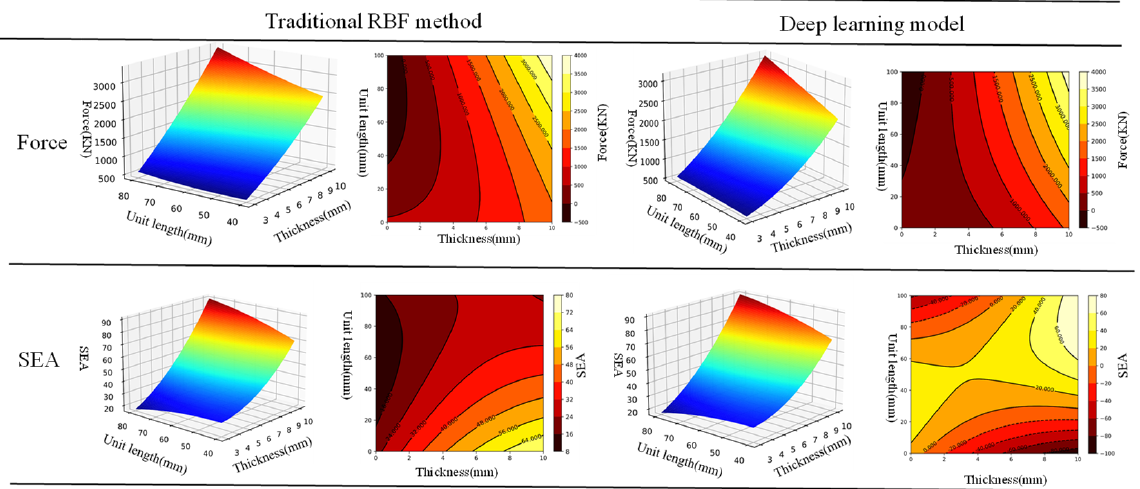
Figure 10. Estimation of few-shot learning model.